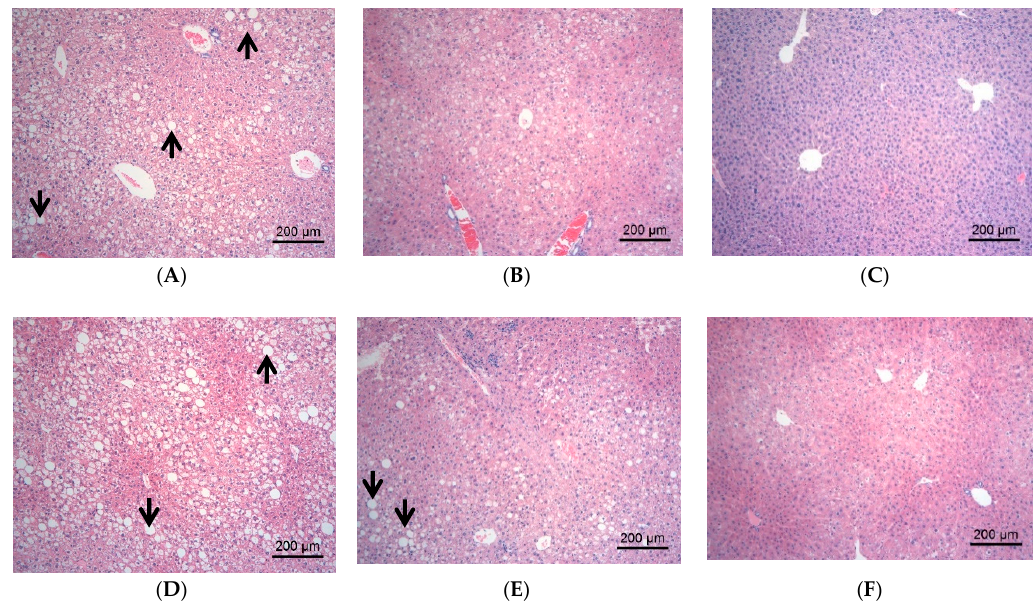
Figure 3. Pathological changes of liver tissues observed under light microscope. The representative areas of fatty degeneration of liver cells were indicated via black arrows, in which some fat droplets were observed under light microscope. ( A ) DM group, fatty degeneration of liver cells by approximately 80 − 90%; ( B ) DMMET130 group, fatty degeneration and balloon denaturalization of liver cells by approximately 30 − 40% and 10 − 20%; ( C ) Control group, normal morphology of liver cell; ( D ) DMDJP25 group, fatty degeneration of liver cells by approximately 70 − 80%; ( E ) DMDJP50 group, by approximately 40 − 50%; and ( F ) DMDJP100 group, by approximately 10 − 20%.